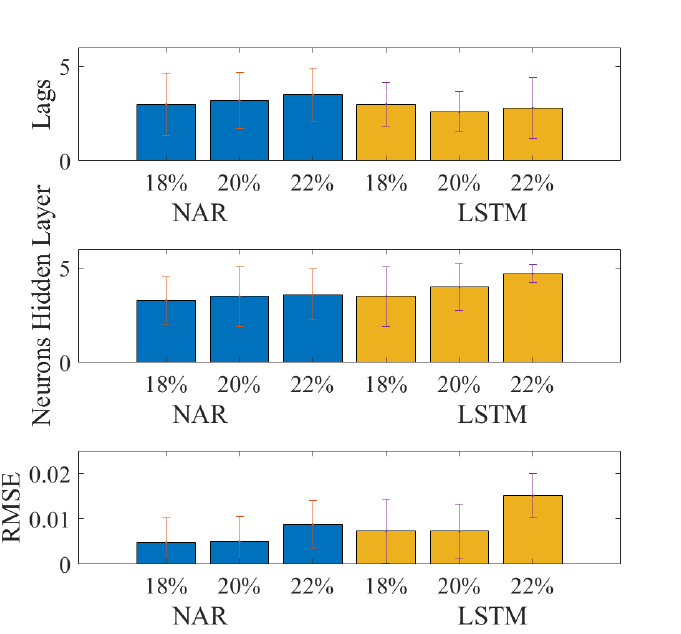
Figure 16. Resume of Results for the NAR and LSTM models for Sweden